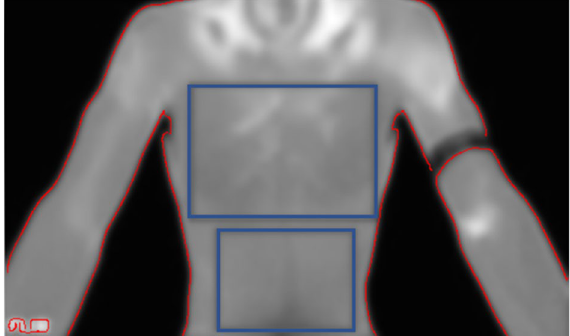
Figure 1. Manually selected ROIs for the chest and